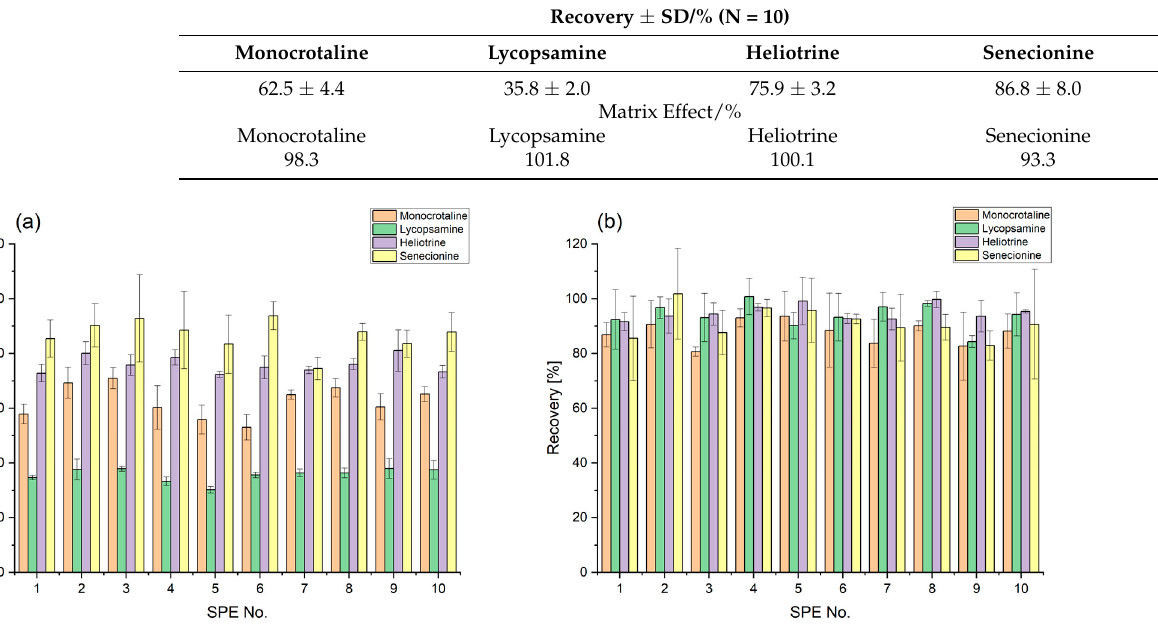
Table 3. Recoveries and matrix effect of a 12.5 µ g L − 1 spiked honey sample after solid phase extraction with HNT-PhSO 3 H as solid material.